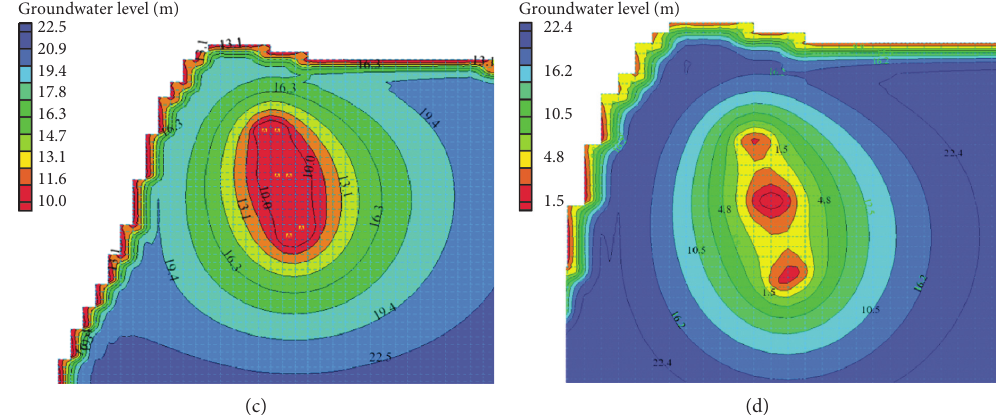
Figure 7: Contours of groundwater level after each dewatering stage. (a) After the first stage of dewatering. (b) After the second stage of dewatering. (c) After the third stage of dewatering. (d) After the fourth stage of dewatering.